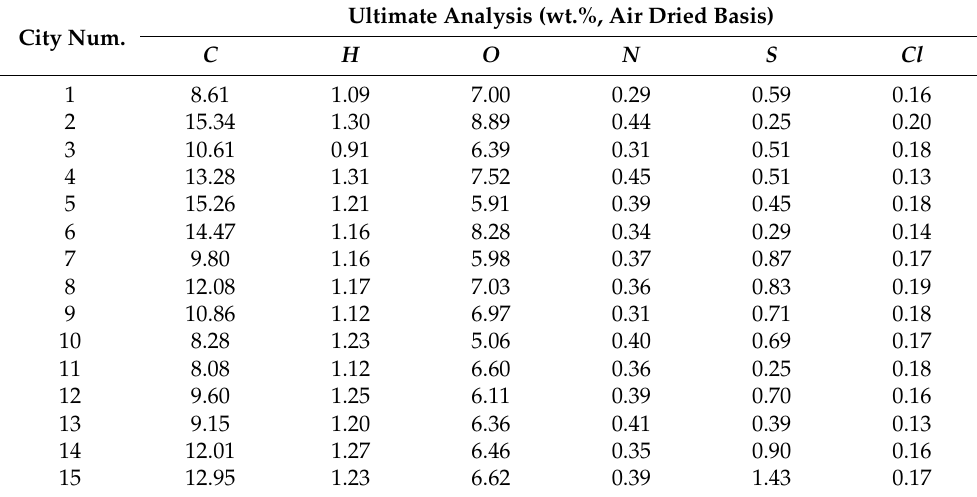
Table 2. The ultimate analysis of MSWs of 15 cities. City